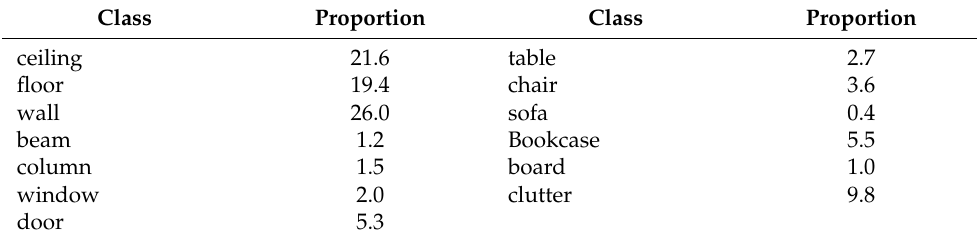
Table 1. Areas 1–5 dataset details ( %